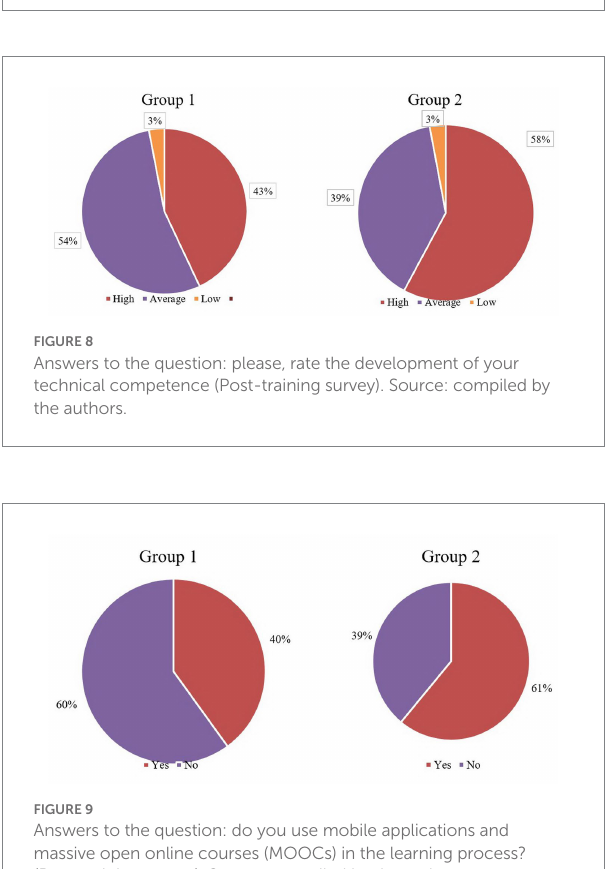
FIGURE 7 Answers to the question: what online educational platforms do you use for your training purposes?. Source: compiled by the authors.